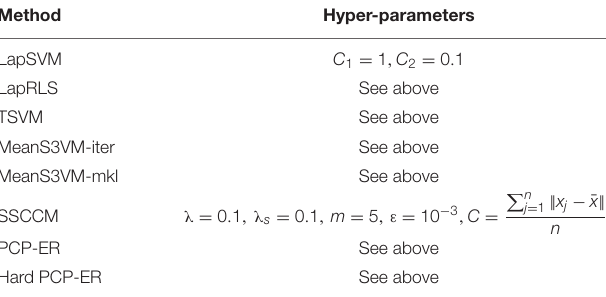
TABLE 2 | Details of hyper-parameters on SEED-IV dataset.